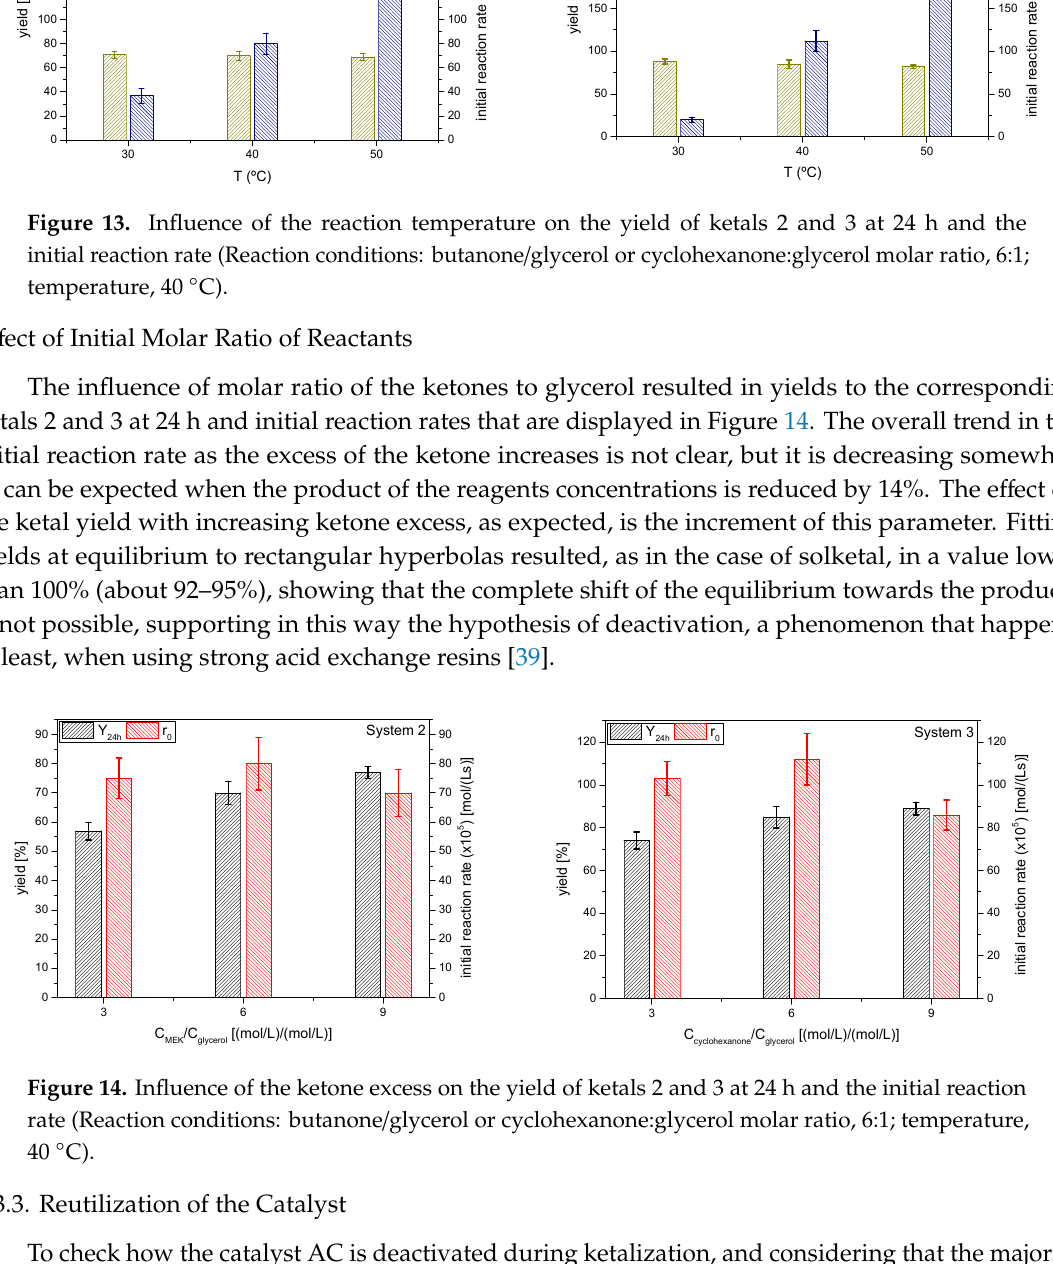
Figure 15. Evolution of the initial ketalization rates for all systems in subsequent reutilization cycles (System 1: acetone; System 2: butanone or methylethylketone (MEK); System 3: cyclohexanone). Reaction conditions: 25 °C, 50 g/L catalyst AC (system1); 40 °C, 200 g/L catalyst AC (system 2); 40 °C, 50 g/L catalyst AC (system 3); ketone/glycerol molar ratio = 6 (all systems). If the three systems under study are compared, it is also evident that chemicals in system 1 are less deleterious to the catalyst activity than those of the other two systems. As the difference is due to the ketone and the ketal in each of the systems and blockage is a possible deactivation mechanism, it could be guessed that ketones and ketals are more prone to remaining in the solid surface for systems 2 and 3 during the acetone washing processes after each cycle. This type of behavior is also observed with strong acid exchange resins for the first system (solketal or ketal 1) [39].